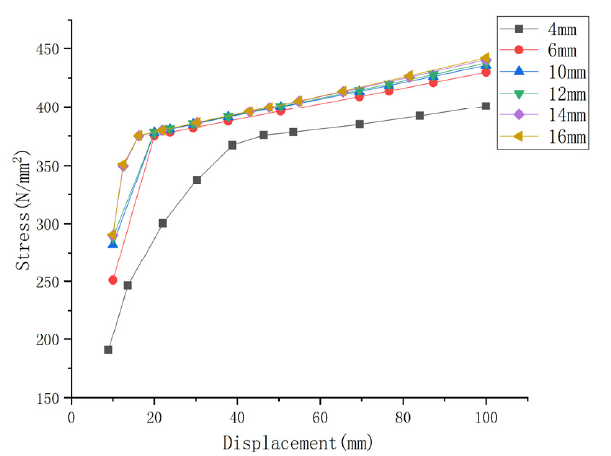
Figure 18. Stress history at C w .